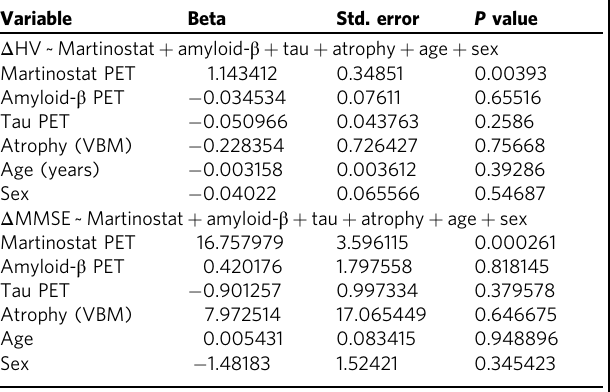
The table shows the results of beta, standard error, and P value coef fi cients of the linear regression models presented in Fig. 4d, e. [ 11 C]Martinostat SUVR predicted a 1-year decrease in hippocampal volume (HV) (neurodegeneration) and worsening in mini-mental state examination (MMSE) scores (cognitive decline) in a subset of our population ( n = 26; 13 CU, 7 MCI, 6 AD dementia), accounting for amyloid- β PET SUVR, tau PET SUVR, atrophy (VBM), age (years) and sex (female = 1). The imaging biomarker values were extracted from the brain regions showing [ 11 C]Martinostat reduction in AD (Fig. 2c). For changes ( Δ ) in HV and MMSE score, lower scores represent a decrease in brain volume and cognitive decline,